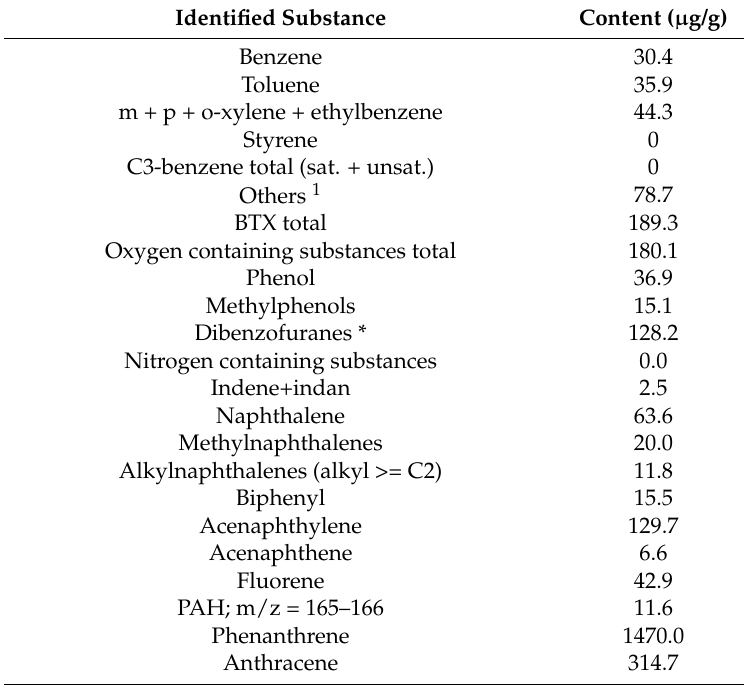
Table 7. Composition of organic substances captured on the filtration